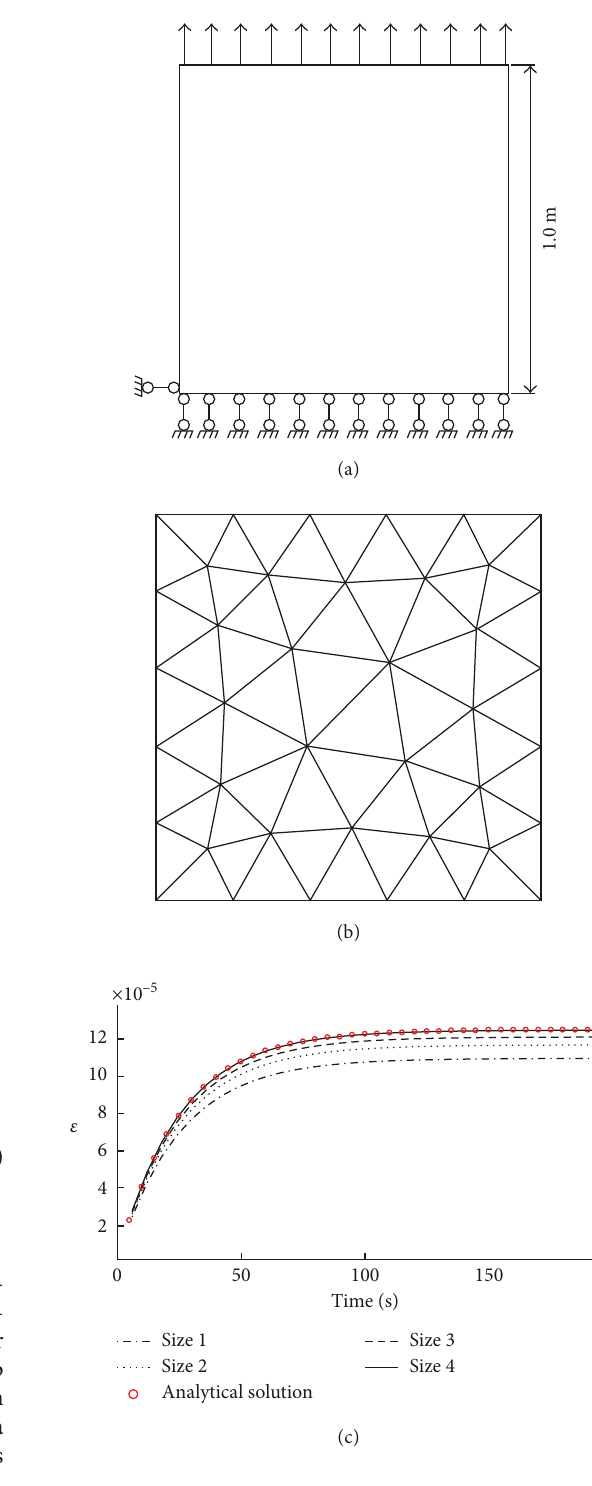
Figure 4: Convergence check of the mechanical model: (a) sim- ulation specimen; (b) meshing scheme; (c) comparison between the analytical and the simulated strain evolution with time (the size means the ratio of the average element area to the specimen area: size 1 2 . 4 (cid:31) ×